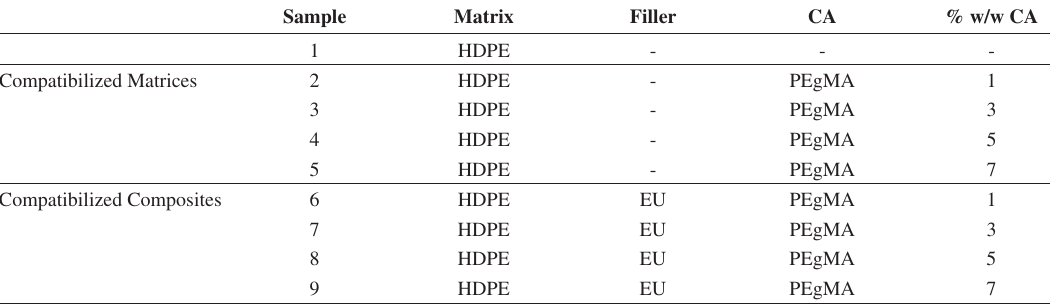
Table 1. Formulation of compatibilized matrices and